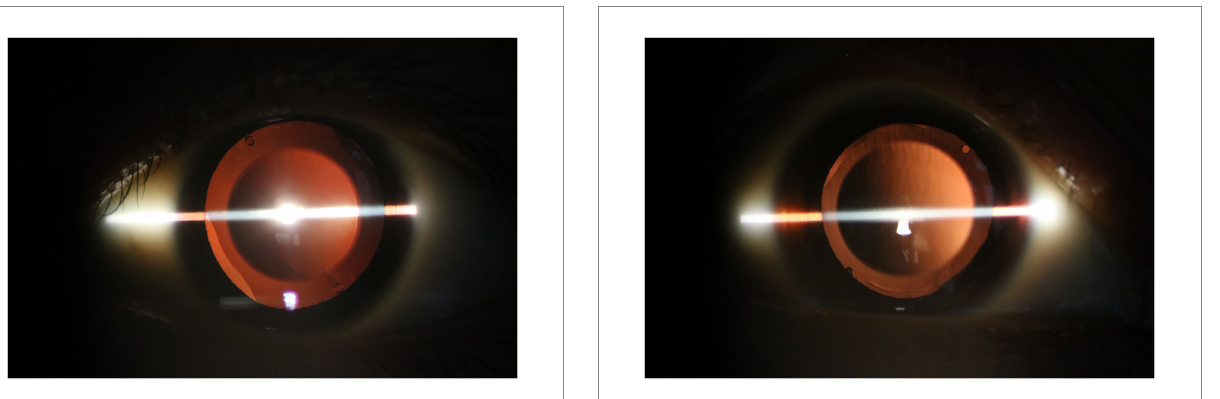
FIGURE 5 The implantable collamer lens position has remained well in situ for 2.5 years following rotation to the oblique position in patient C.